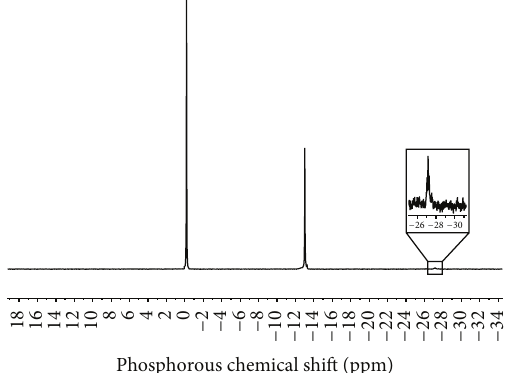
Figure 2: 31 P NMR spectrum of the PPA (105% grade) used for bitu- men